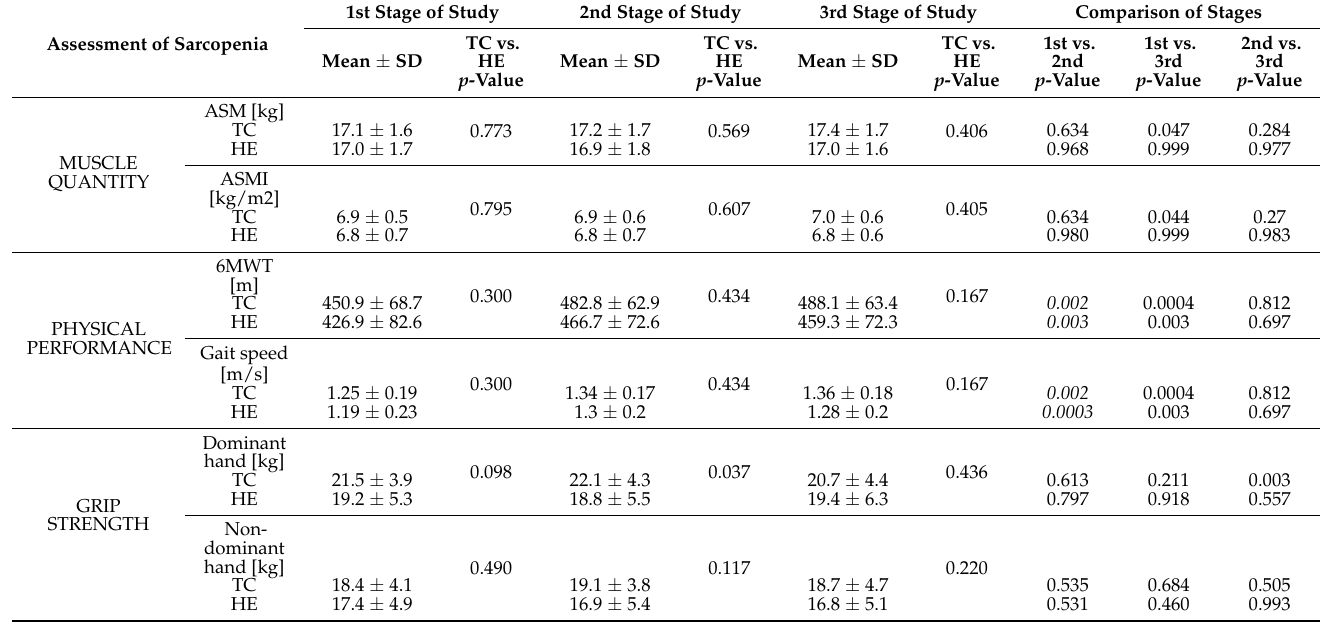
Table 4. Assessment of